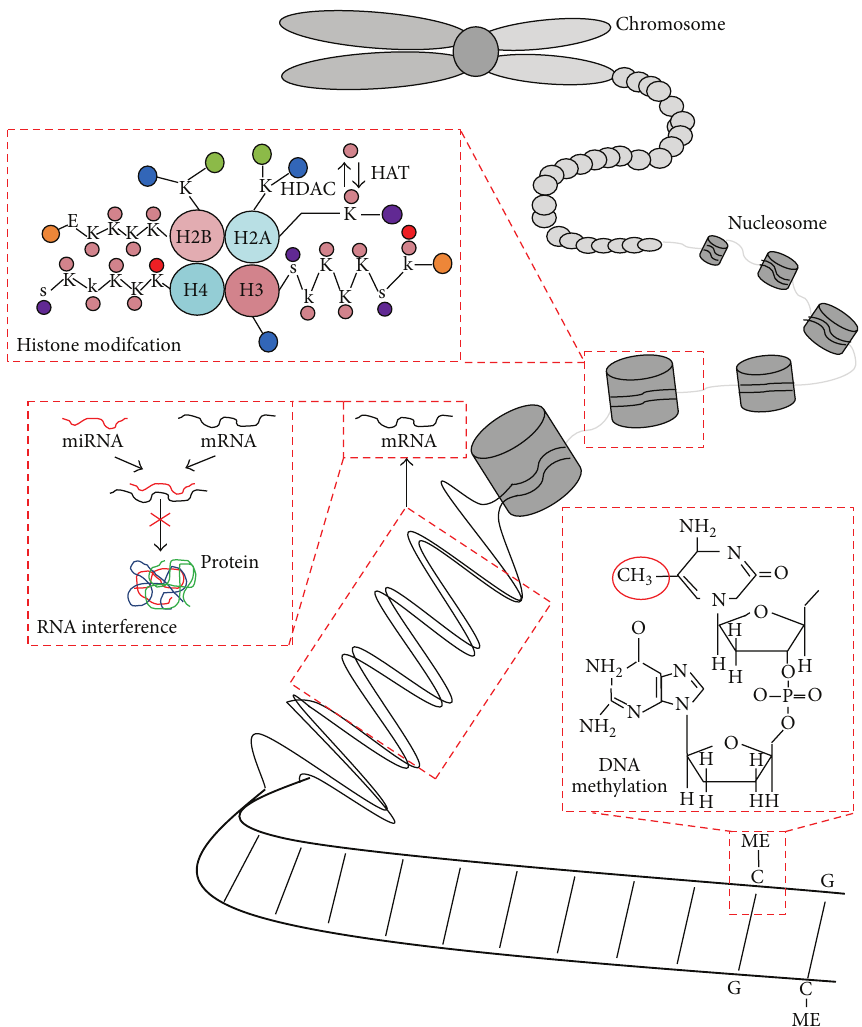
Figure 5: Mechanisms of epigenetic regulation . Three main forms of epigenetic modification include histone modification, RNA interference, and DNA methylation. Histone (chromatin) modification refers to the covalent posttranslational modifications to the N-terminal tails of the four core histone proteins; this modification is commonly acetylation/deacetylation changes at lysine residues mediated by histone acetyltransferases (HATs) and histone deacetylases (HDACs). RNA interference is predominantly mediated through microRNAs, which inhibit the translation of mRNA into protein. DNA methylation occurs at cytosine residues of CpG dinucleotides and acts to regulate gene expression. Pink circle = acetyl group, purple circle = phosphate group, red circle = methyl group, blue circle = carboxyl terminus, green circle = ubiquitin, orange circle = amino terminus, k = lysine, E = glutamic acid, S = serine. H2A, histone 2A; H2B, histone 2B; H3, histone 3; H4, histone